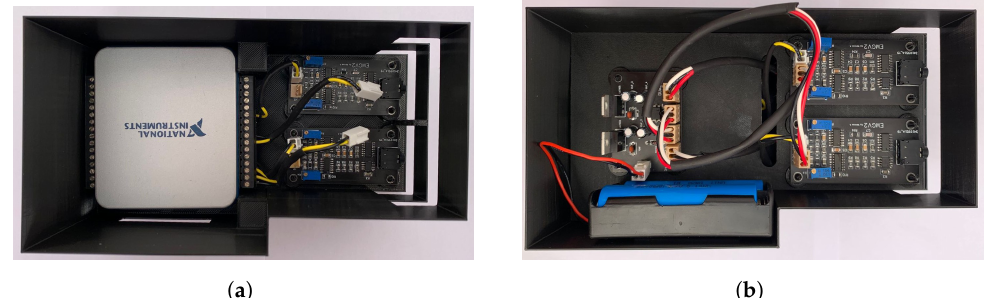
Figure 2. View ( a ) of the first floor of the EMG acquisition system where the two acquisition channels and the power supply system are located, and ( b ) the second floor of the EMG acquisition system where the two remaining channels and the acquisition system are